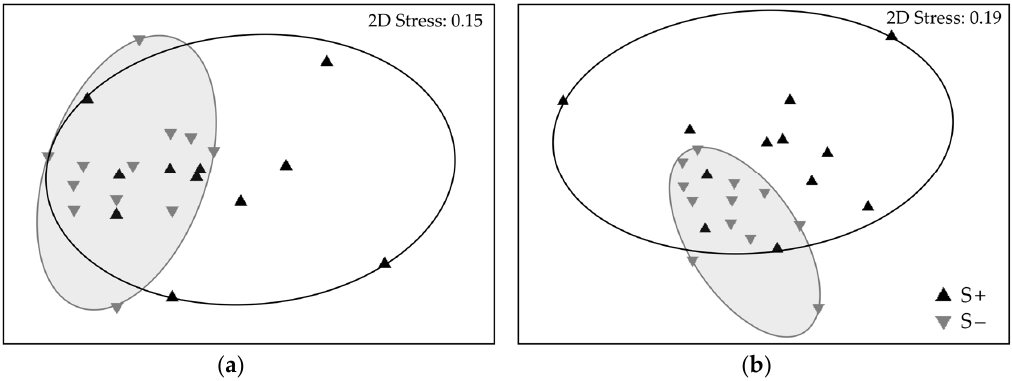
Figure 4. Non-metric multidimensional scaling (nMDS) plots showing benthic algal assemblage structure in plots where Sargassum horneri was removed (S − ; grey) and in non-removal plots (S+; black) sampled in 2017. Data are presented by season as ( a ) spring and ( b ) summer. N = 24 plots. Analysis used damp biomass with a square root transform and Bray–Curtis similarity index. Two-dimensional (2D) stress values indicate the degree of mismatch between the predicted values from the regression of the similarity matrix and the distances between samples. Table 2. Composition of the native algae present in spring and summer 2017 in unmanipulated (S + ) plots and those where Sargassum horneri was removed (S − ). Data are damp biomass (mean ± SE g · m − 2 ) and the percent contribution of individual taxa to the top 70% of the dissimilarity between S + and S − treatments in SIMPER analysis.